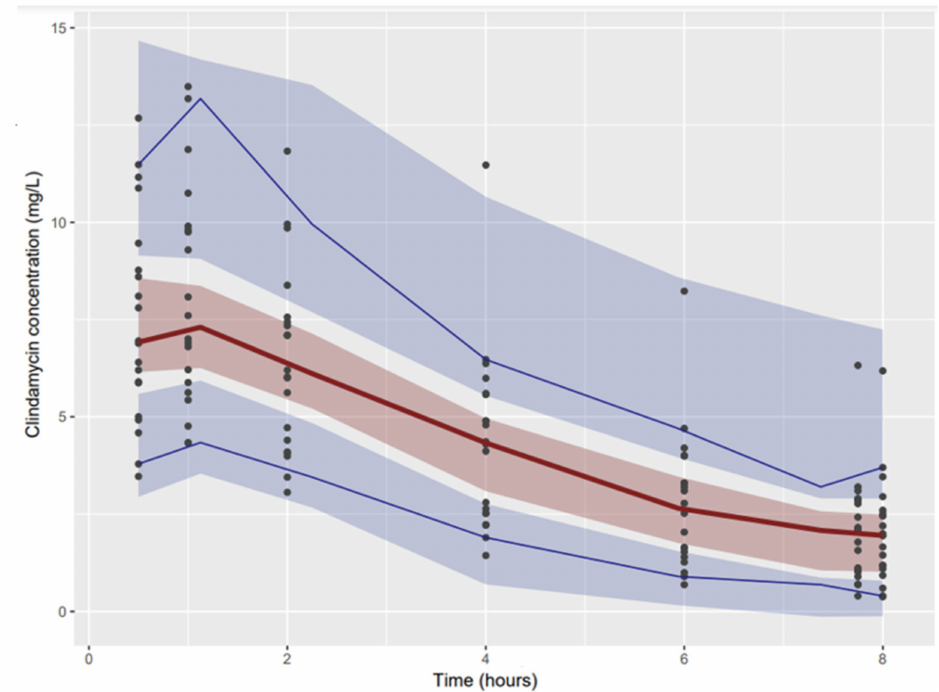
Figure 2. Prediction- and variability-corrected visual predictive (pvcVPC) for clindamycin concen- trations after oral intake using the final model. The lower blue, red and upper blue lines show, respectively, the 10th, 50th and 90th percentiles obtained with observed data. The lower blue, red and upper blue areas represent the 90% confidence intervals obtained with simulated concentrations around their respective 10th, 50th and 90th percentiles.